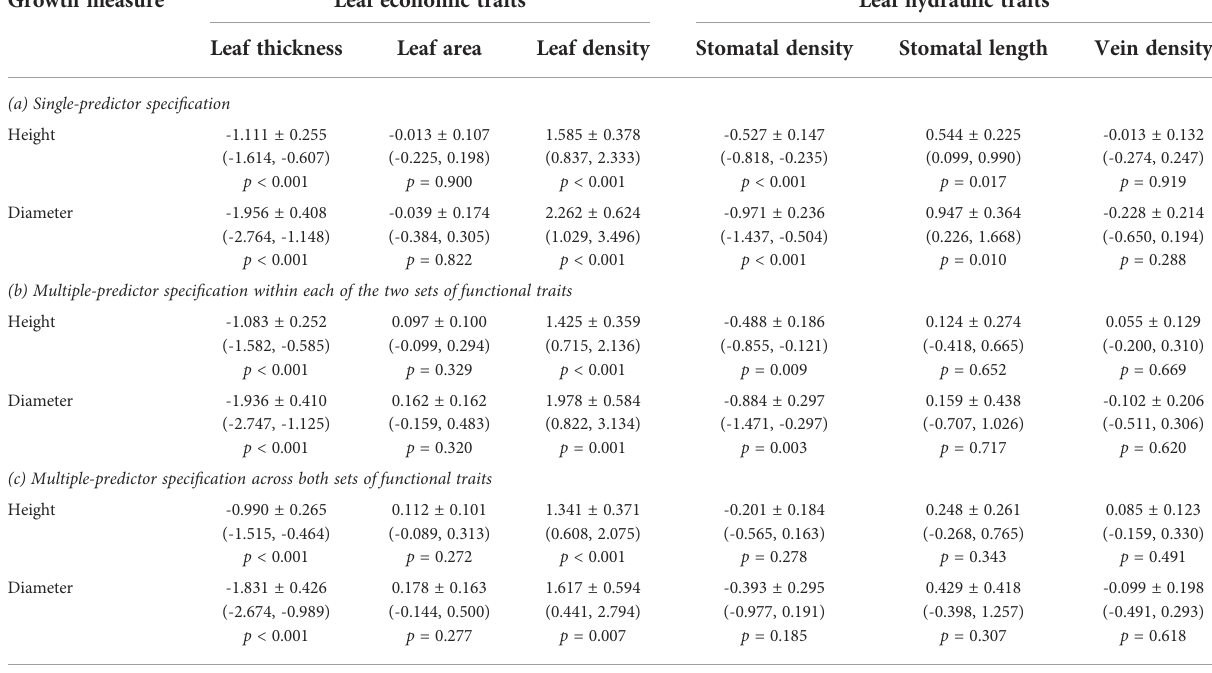
TABLE 2 Relationship of growth performance measured by tree height or diameter with leaf economic and hydraulic traits, assessed in a common-garden fi eld trial of E. pauci fl ora . Growth